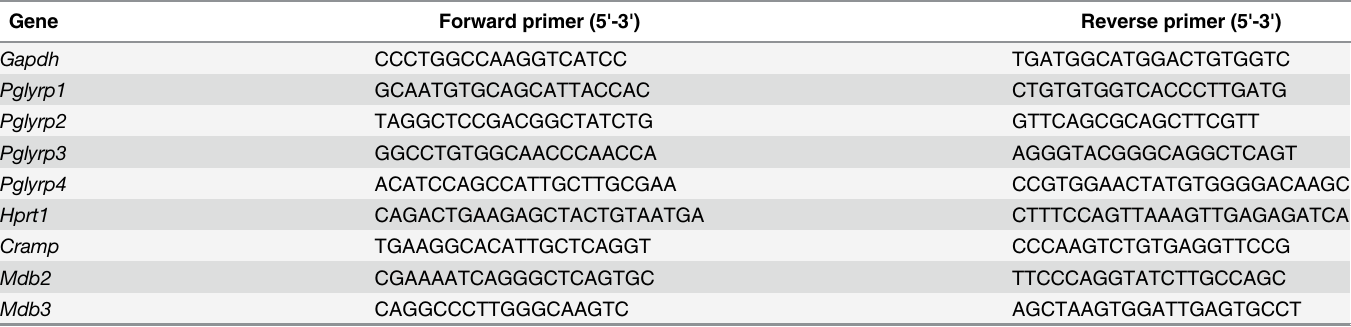
Table 1. Primers used in qRTPCR experiments.